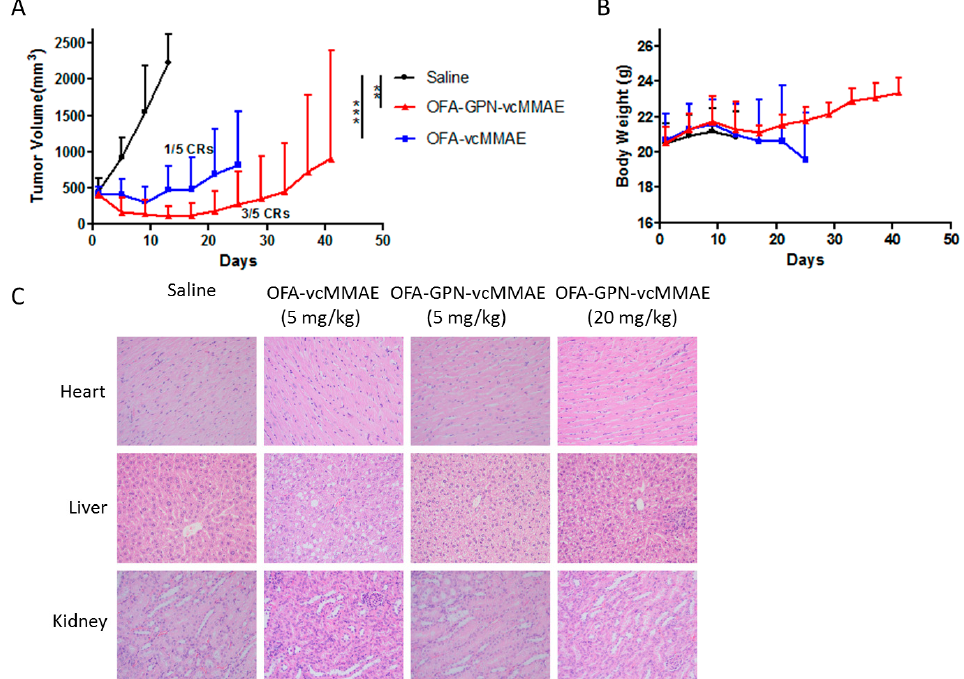
Figure 11. In vivo efficacy and toxicity of OFA-vcMMAE and OFA-GPN-vcMMAE in human tumor xenograft mouse models. ( A ) In vivo antitumor activities of OFA-vcMMAE and OFA-GPN-vcMMAE conjugates. The p -value is indicated as follows: ** p <0.01, *** p <0.001, compared with saline group. ( B ) Body weight monitoring of mice after drug administration; ( C ) Acute toxicity evaluation of mice treated with saline, OFA-vcMMAE (5 mg/kg) and OFA-GPN-vcMMAE (5 mg/kg or 20 mg/kg) via histological sections of the major organs (heart, liver and kidney) after H&E staining. Magnification was 40×.